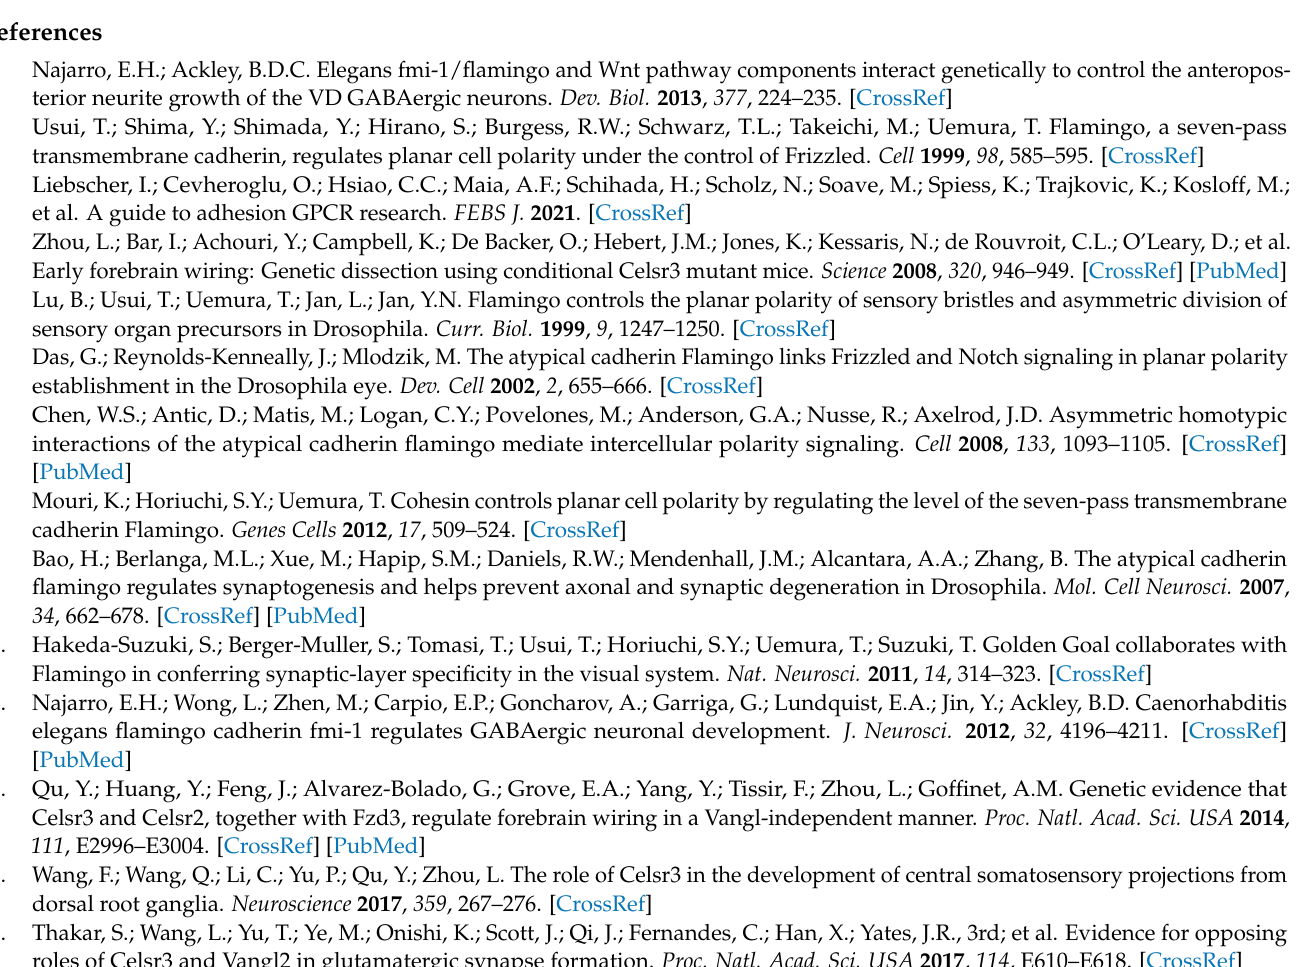
Table S2: Significance testing of syg-1, syg-2, mig-5 and lin-17 ; Table S3: Significance testing of L1 vs.